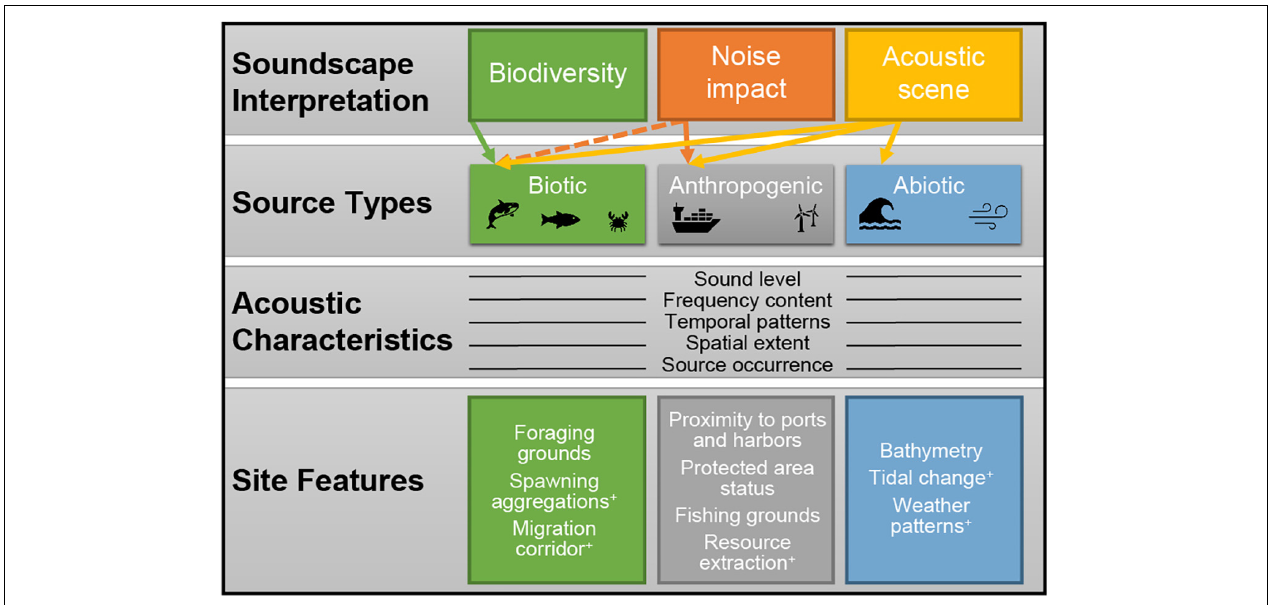
FIGURE 1 | Soundscapes can be interpreted from different perspectives: biodiversity assessment, noise assessment, or acoustic scene assessment. Each interpretation focuses on specific source types (shown by arrows, dashed arrows indicate possible source focus). There are many acoustic characteristics of a soundscape and this list represents some of the more commonly measured and discussed. The features of a listening location are generally site or habitat specific and these listed serve as examples for shallow water marine soundscapes, some of which can be measured using passive acoustics (indicated by +